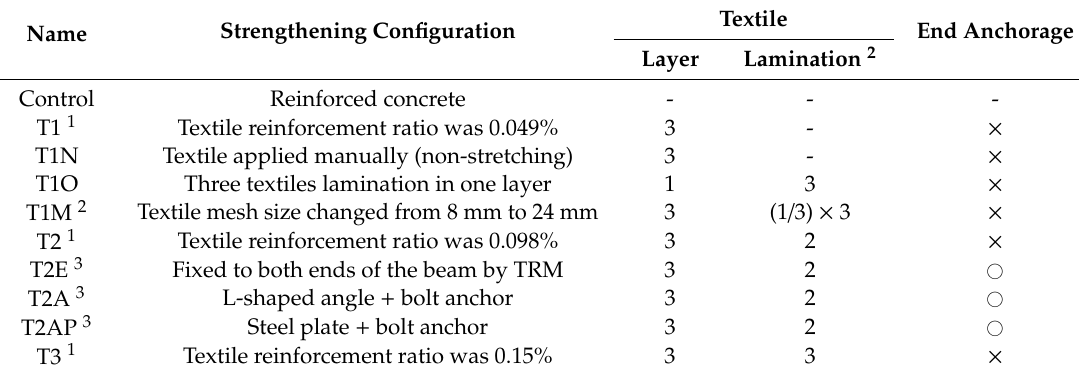
Figure 3. Textile-reinforced mortar (TRM)-strengthening device with textile stretching. Table 5. Detailed specifications of study specimens.